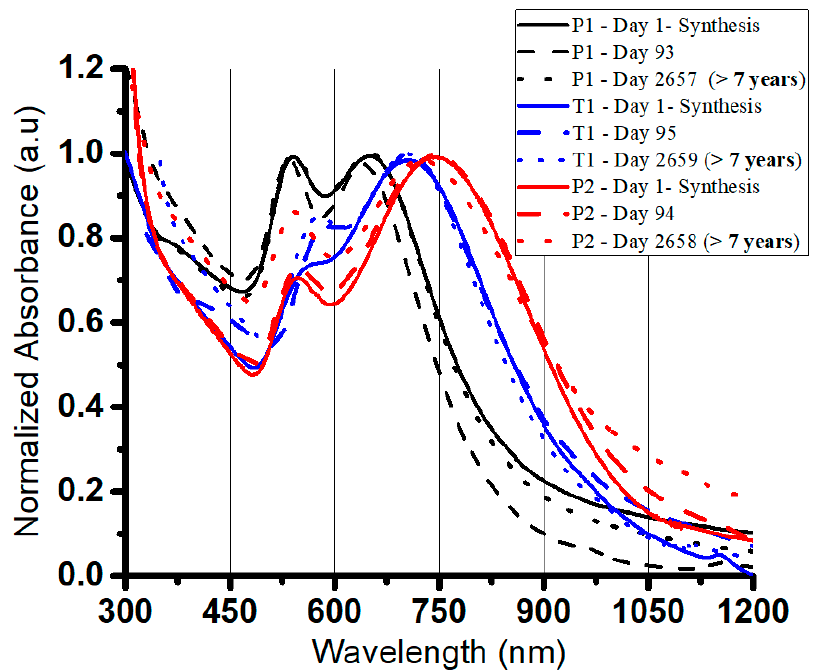
Figure 6. Demonstration of extreme time-dependent stability of NIRAuNM stabilized within PNIPAm- co -allylamine microgels. P1, T1, and P2 refer to NIRAuNM samples prepared by photochemistry, heating, and photochemistry, respectively, within PNIPAM- co -allylamine microgels